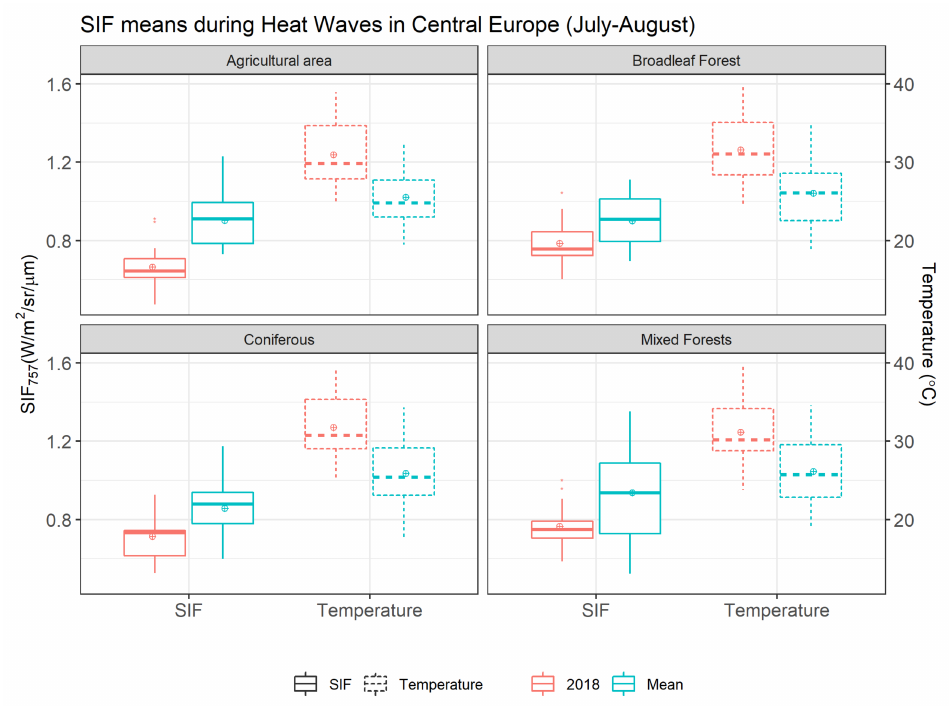
Figure 5. Boxplots illustrating SIF variation across the four vegetation type during the heatwave (15 July to 15 August) in central Europe (i.e., Germany, Denmark, Belgium, and Netherlands) along with temperature di ff erences. Dots inside the boxplots represent the corresponding mean